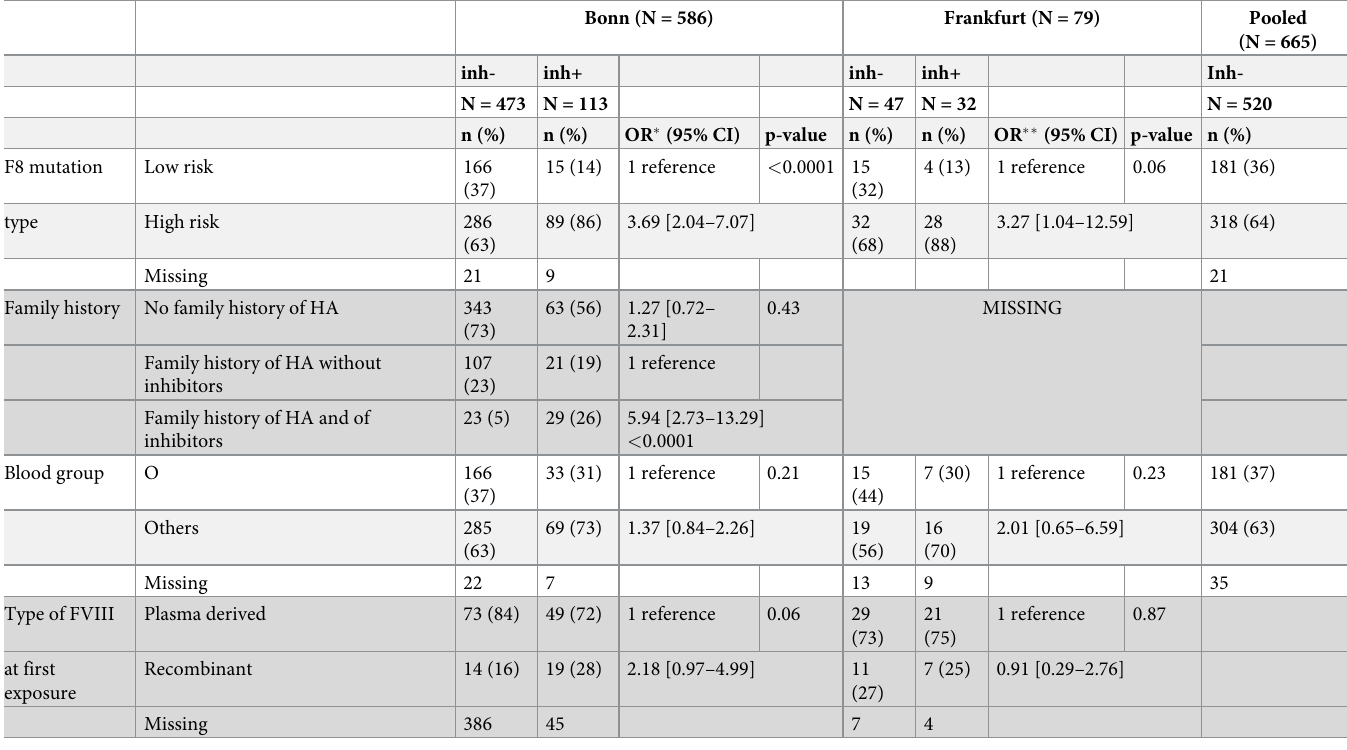
Table 2. Univariate odds ratios for patient, disease and treatment risk factors for inhibitor